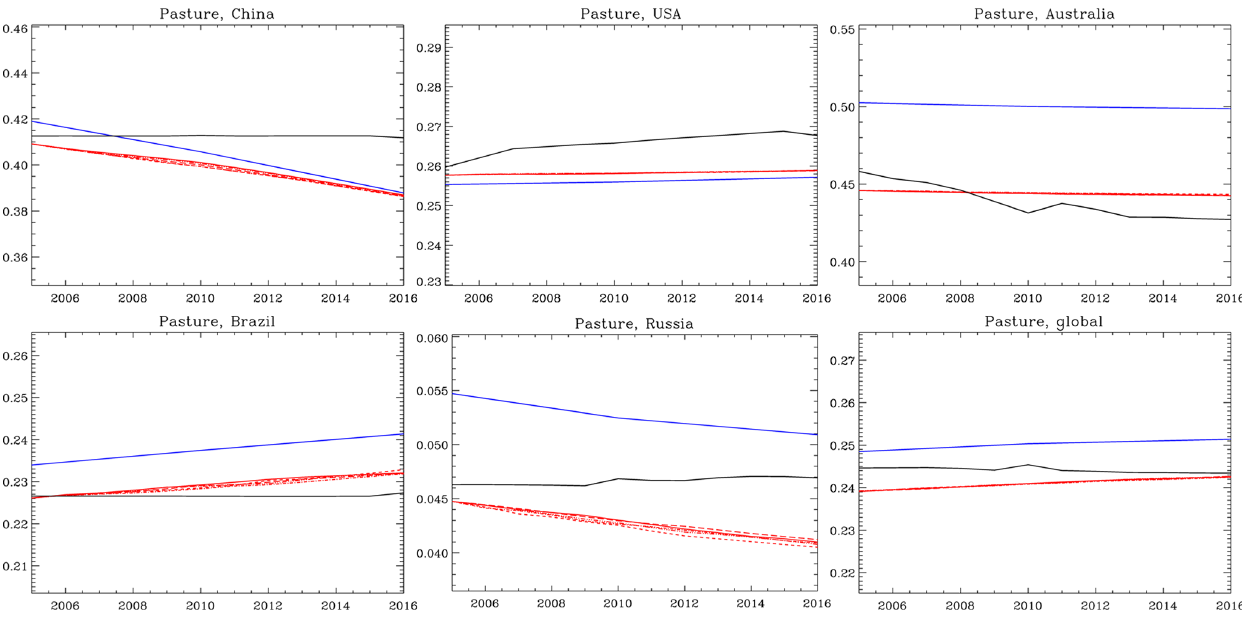
Figure 8. Same as Fig. 7 but for the comparison of historical pasture area simulated by MIROC-INTEG-LAND (red), AIM/CGE (blue), and LUH (black), using the ratio of pasture area to total